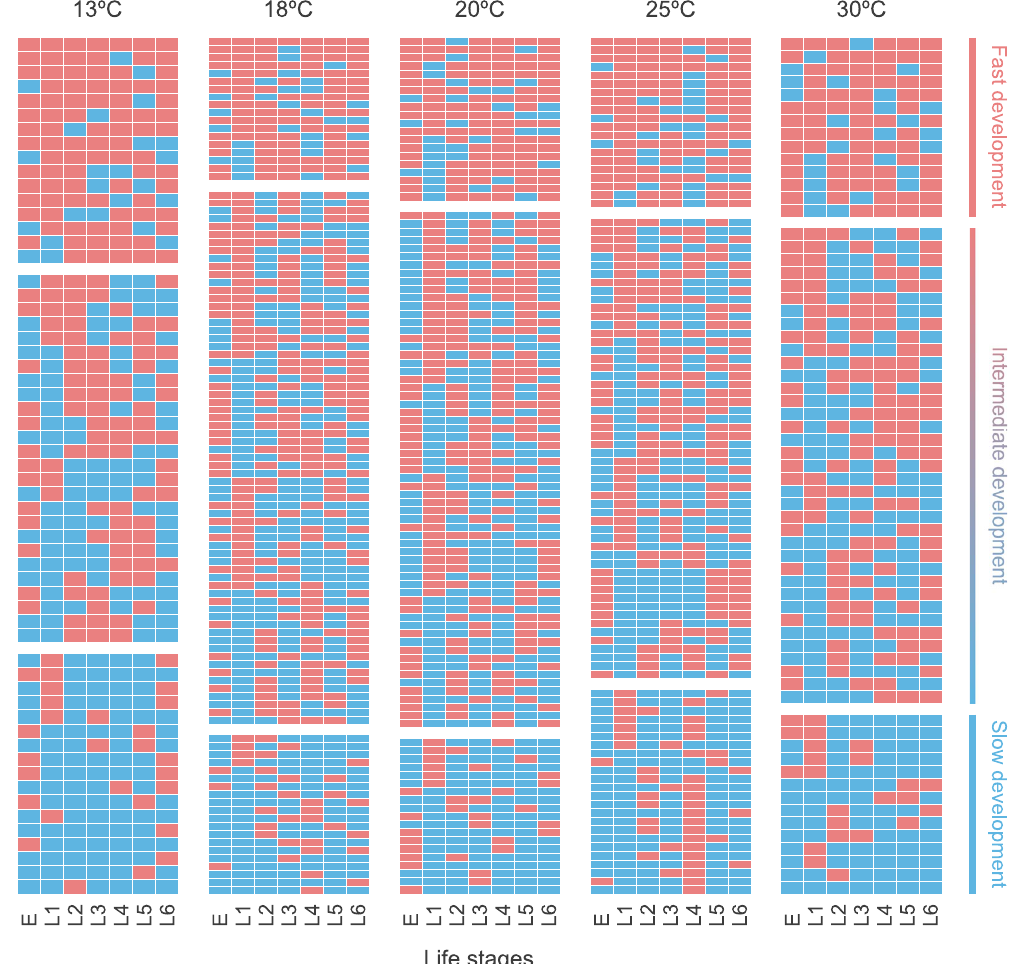
Figure 2. Shifts in pace-of-life development strategies observed within the population of C. incommoda across life stages, for five populations reared at 13 °C, 18 °C, 20 °C, 25 °C and 30 °C. Each row represents an individual followed separately across all life stages (in column, E = eggs, and L1 to L6 = larval instars). A red square means that the individual development rate stands in the upper half (fast strategy) for the considered life stage, while the blue square stands in the lower half (slow strategy). We defined the slow individuals (29%, 19%, 18%, 24% and 22% of the populations reared at 13, 18, 21, 25, and 30 °C, respectively) and fast individuals (30%, 17%, 19%, 20% and 22% of the populations reared at 13, 18, 21, 25, and 30 °C, respectively) as individuals that stayed within the same category at least five out seven life stages (separated by white